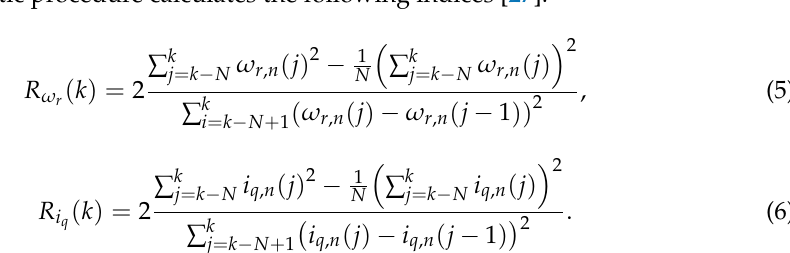
Figure 1. Scheme of the parameter identification algorithm.